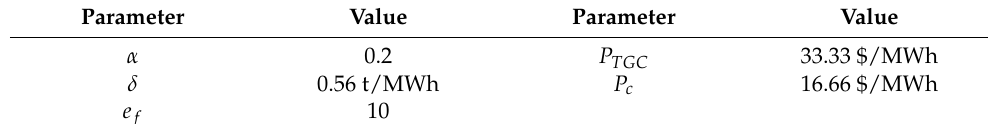
Table 2. Other parameters of electricity trading.